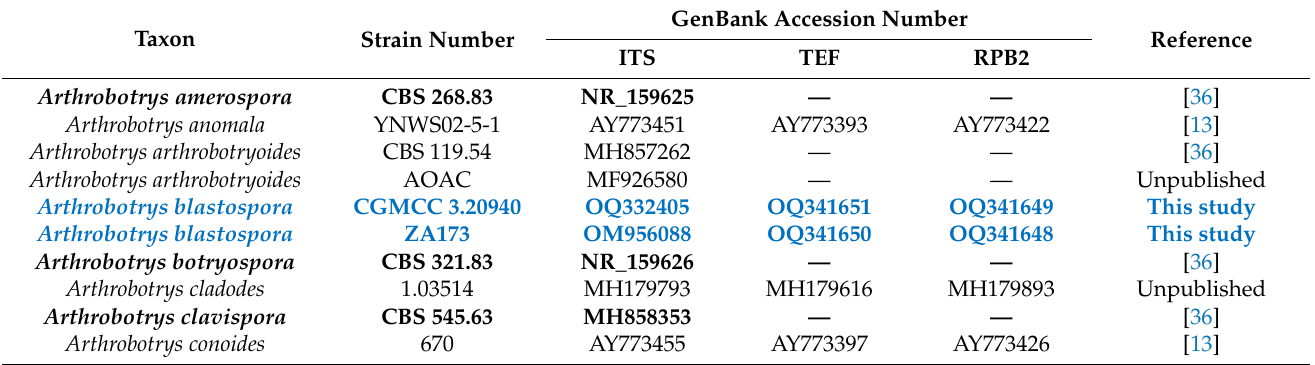
Table 1. The GenBank accession numbers of the isolates included in this study. The ex-type strains are in bold. The newly generated sequences are indicated in